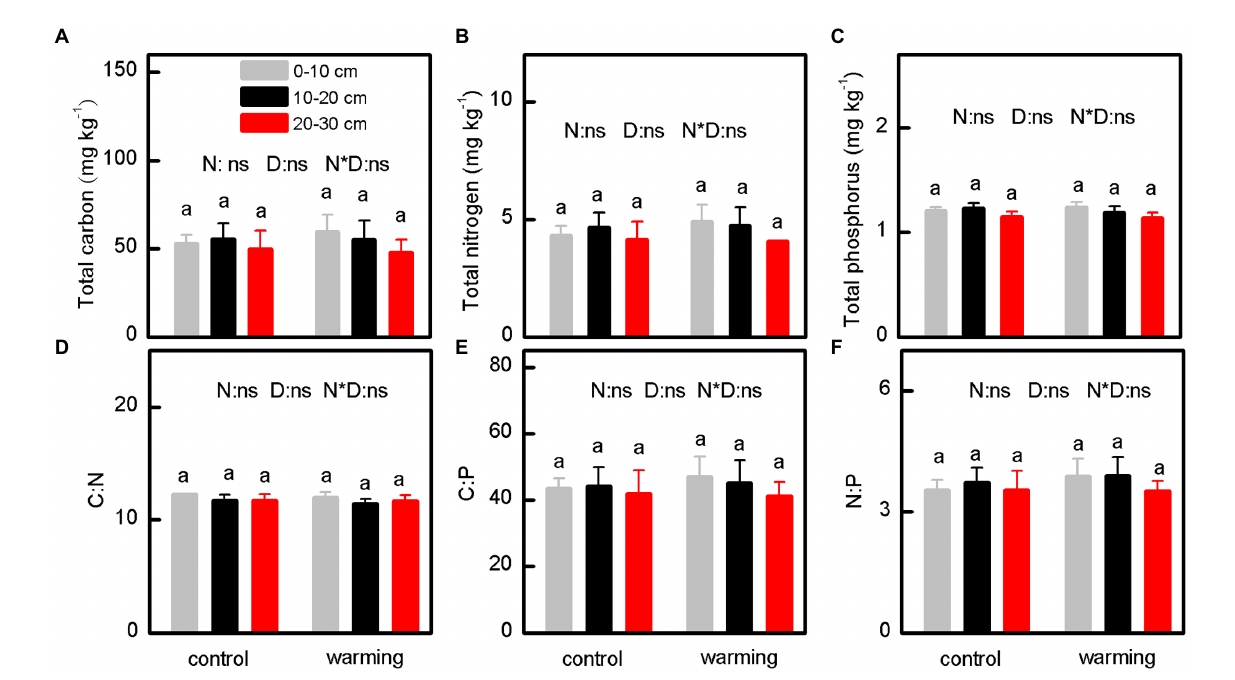
FIGURE 3 The concentration of total carbon (A) , total nitrogen (B) , total phosphorus (C) , and the ratio of C:N (D) , C:P (E) and N:P (F) of soil under control and warming. p -value of the ANOVA of treatments (control and warming, N), soil depths (0–10, 10–20 and 20–30 cm, D) and interactive of treatments and